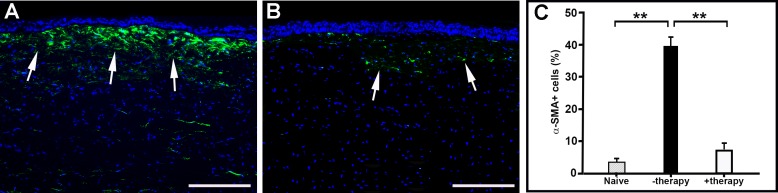
Immunofluorescence images showing stromal expression of α-SMA, a myofibroblast marker, in corneas 21 days post injury in rabbits that did not receive gene therapy (A) and those that received BMP7+HGF gene therapy (B). Quantification graph depicts the significant reduction of α-SMA in the +therapy group compared to the −therapy group (P < 0.001). Scale bar: 100 μm.